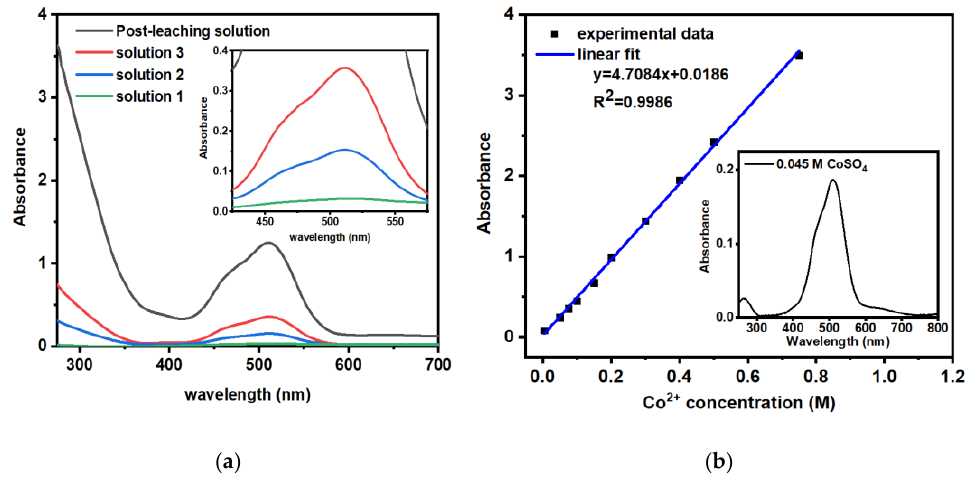
Figure 1. ( a ) UV-vis spectra of post-leaching solution and solutions 1–3 obtained after SPIONs synthesis (measurements without SPIONs in solution) and ( b ) calibration curve of Co 2+ concentration, where inset presents the 0.045 M CoSO 4 reference solution.